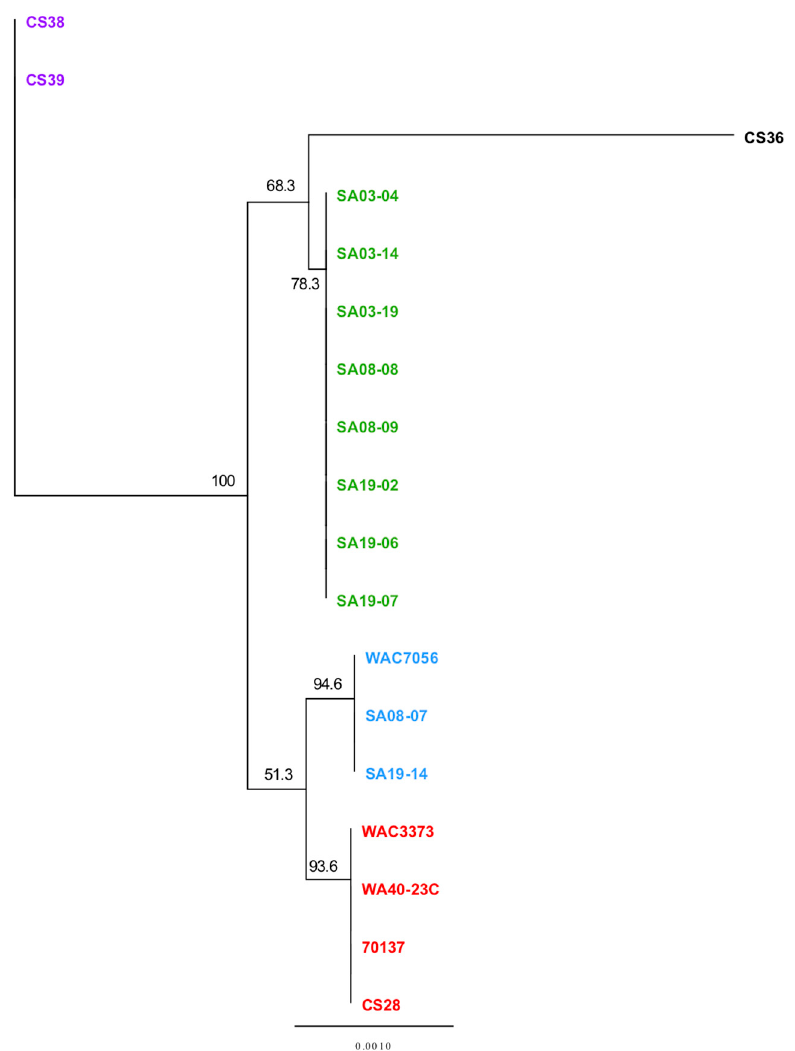
Figure 8. Phylogenetic analysis of the R. toxicus trehalose biosynthetic pathway genes. Neighbor-joining trees were based on concatenated DNA sequences of four tunicamycin biosynthesis genes ( tps , tpp , treY and treZ ) from 18 R. toxicus isolates and calculated using the Jukes-Cantor method to compute evolutionary distances. Confidence intervals were assessed using the bootstrap method with 1000 replications. Strains within the phylogenetic tree are color-coded based on genetic population. Green: RT-I; blue: RT-II; red: RT-III; black: RT-IV; purple: RT-V. Exopolysaccharide (EPS) interacts with the environment (vector, host, etc.) and may play a role